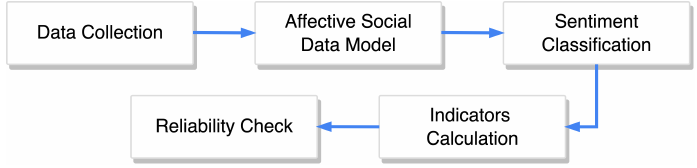
Figure 1. Pipeline for measuring